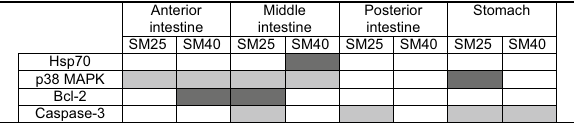
8 preparations from different animals. * p < 0.05 compared =